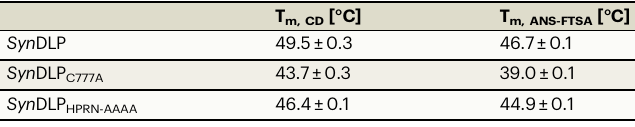
Table 2 | Transition temperatures of Syn DLP variants deter- mined via CD spectroscopy and